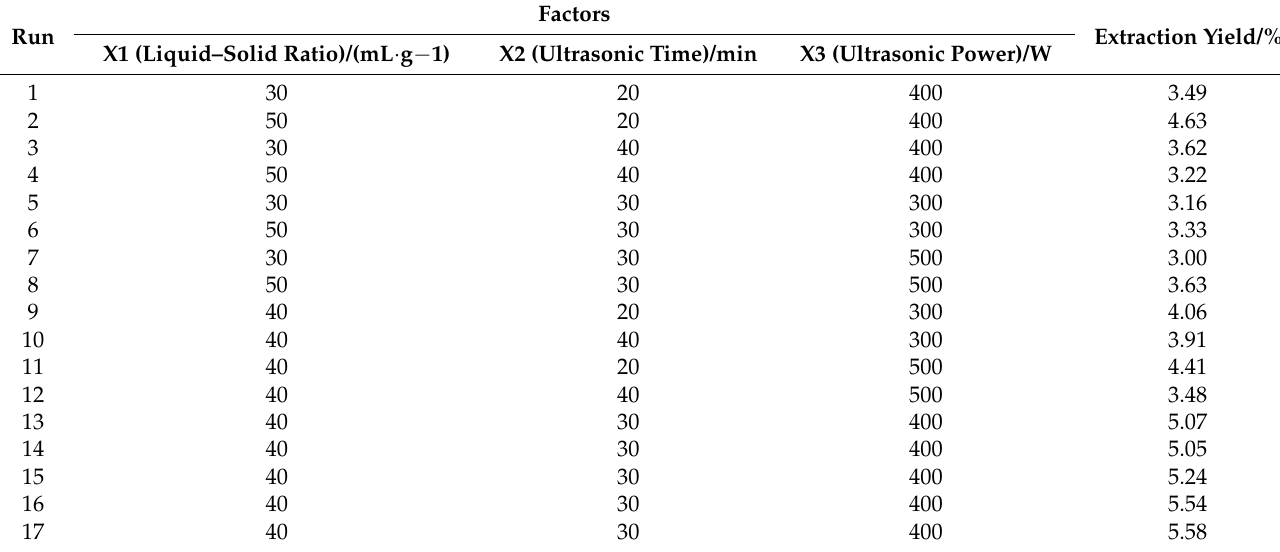
Table 2. Experimental design and results of